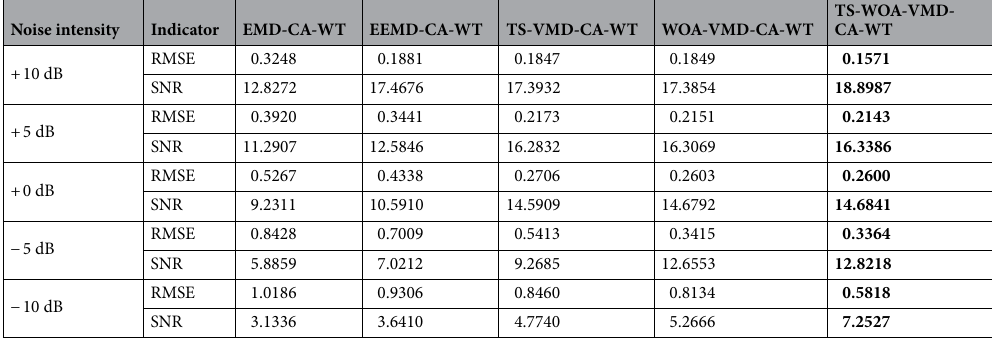
signal. Moreover, it effectively avoids the burr and signal distortion.